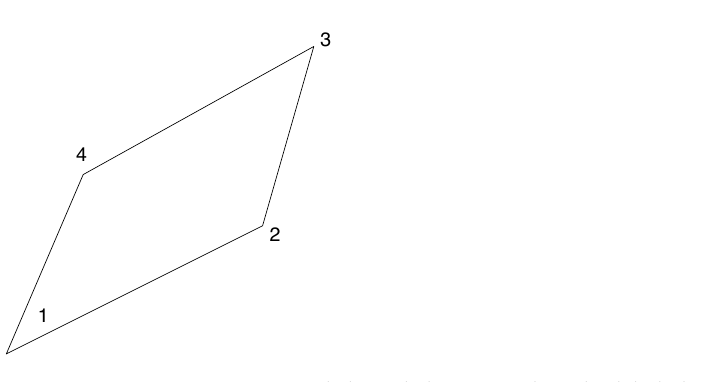
Figure A1. A representative quadrilateral element with nodes labeled 1 to